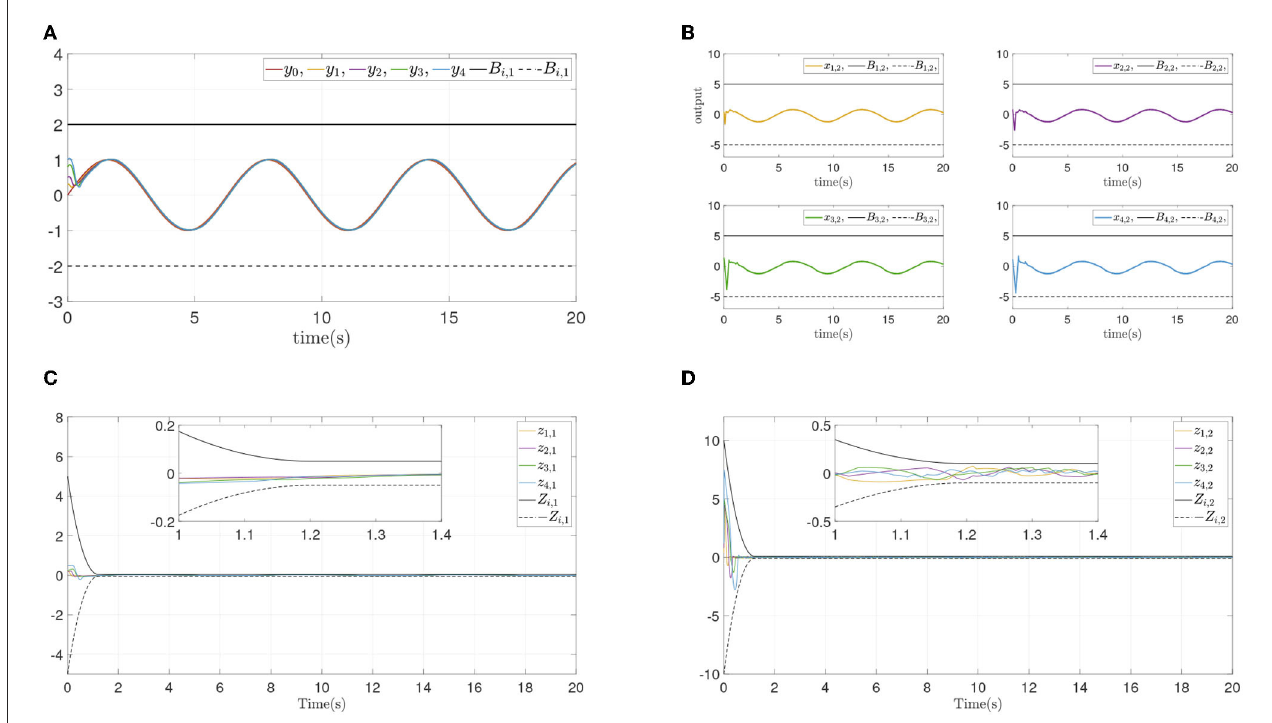
FIGURE4 Simulation results of Example A case II. (A) Follower’ outputs y i . (B) Followers’ states x i ,2 . (C) Synchronization error z i ,1 . (D) Dynamics error z i ,2 .